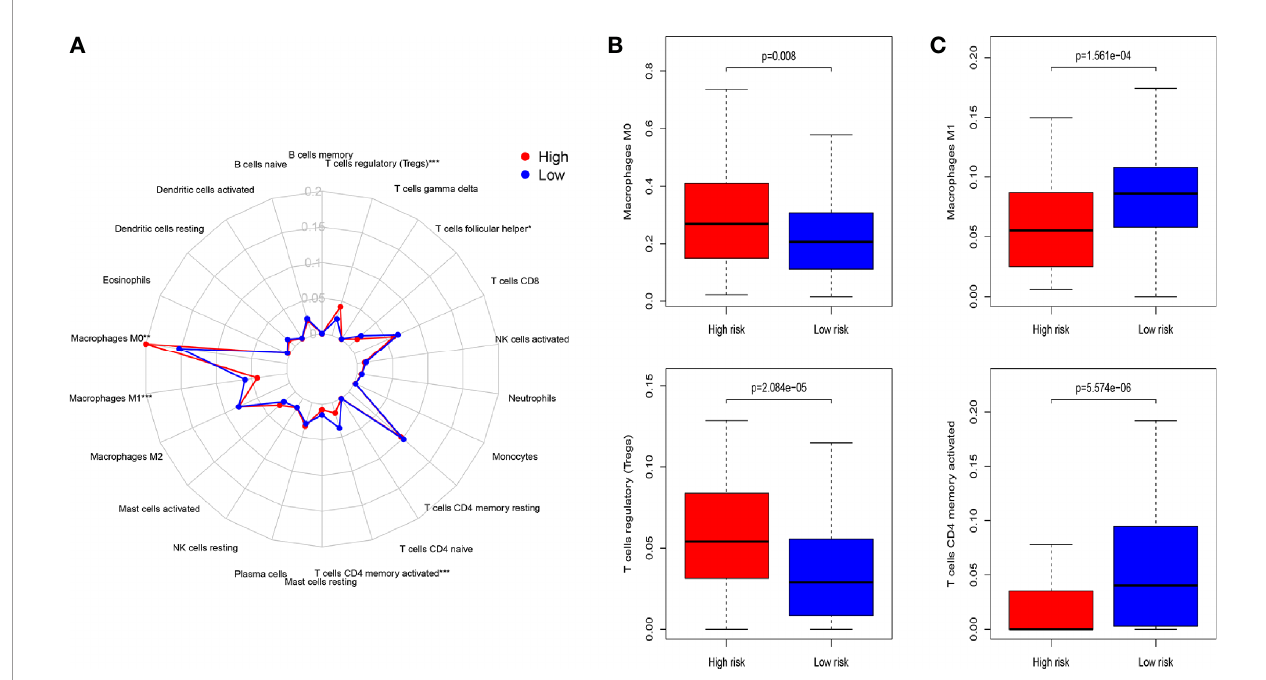
FIGURE 4 | (A) Summary of the 22 immune cell types abundance estimated by “ CIBERSORT ” for different risk groups. (B) The differences of 22 immune cell types abundance within different risk groups. Treg cells ( p < 0.001) and macrophage M0 ( p =0.015) were signi fi cantly highly expressed in the high-risk group. (C) Activated memory CD4 + T cells and macrophage M1 were signi fi cantly higher in the low-risk group (all p < 0.001). P -values were based on t-test. (*P < 0.05, **P < 0.01, ***P <